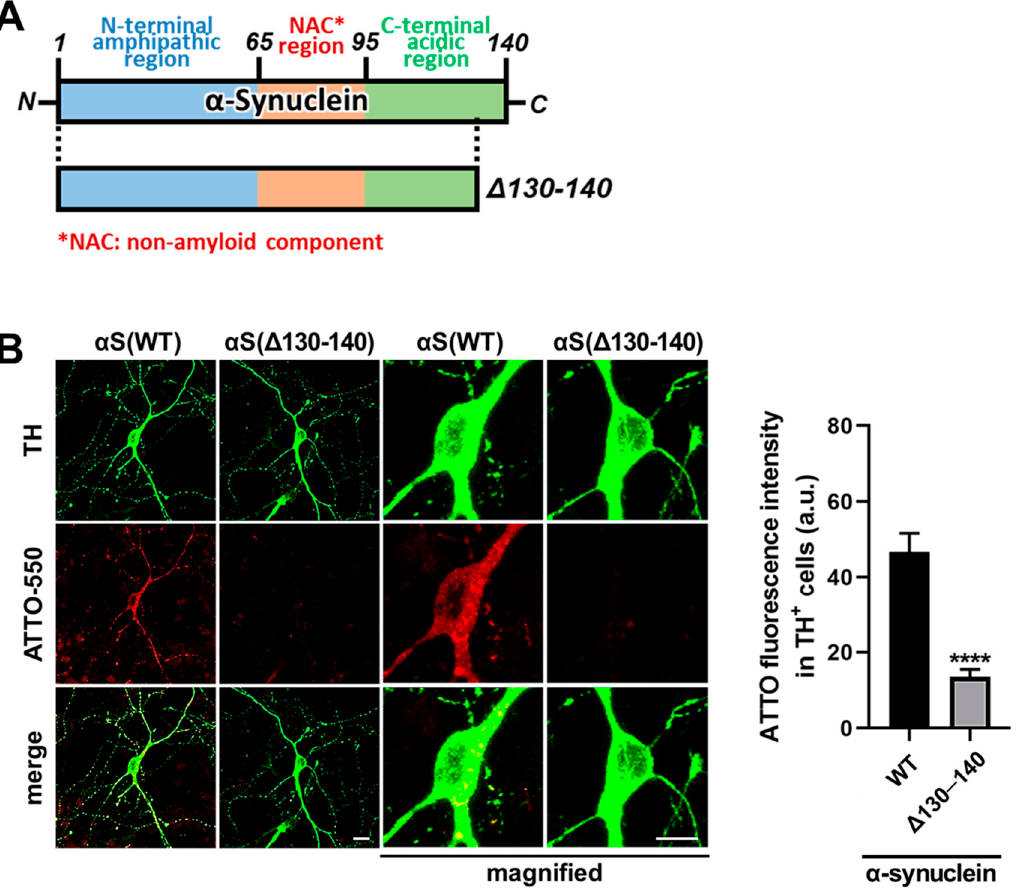
Figure 4. Structure of α -synuclein mutant lacking C-terminal region and the effect of C-terminus deletion on the ability of α -synuclein uptake in dopaminergic neurons. ( A ) The structure of a mutant form of α -synuclein with an 11-amino acid deletion in the C-terminal region. ( B ) Cultured mesencephalic neurons were treated with 1 µ M ATTO-550-labeled wild type or ∆ 130–140 deletant α -synuclein monomer for 48 h. C-terminus deletion decreased the ability of α -synuclein uptake. The magnified images were enlarged by three times. Scale bar 10 µ m. The right graph shows the quantitative analysis of ATTO-550-labeled α -synuclein monomer fluorescence intensity of individual TH + neurons. **** p < 0.0001 in α -synuclein wild type (WT) versus ∆ 130–140 deletant ( ∆ 130–140), n = 27 in three independent